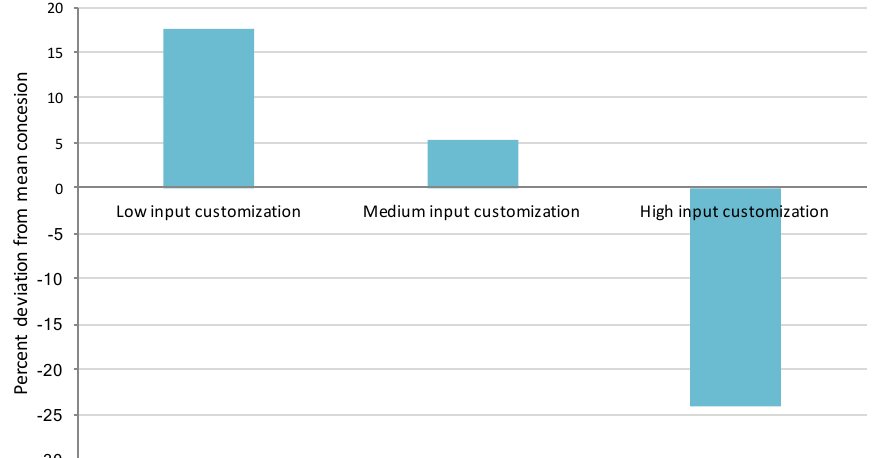
Figure 8. Percent deviation from concession by tercile of input customization